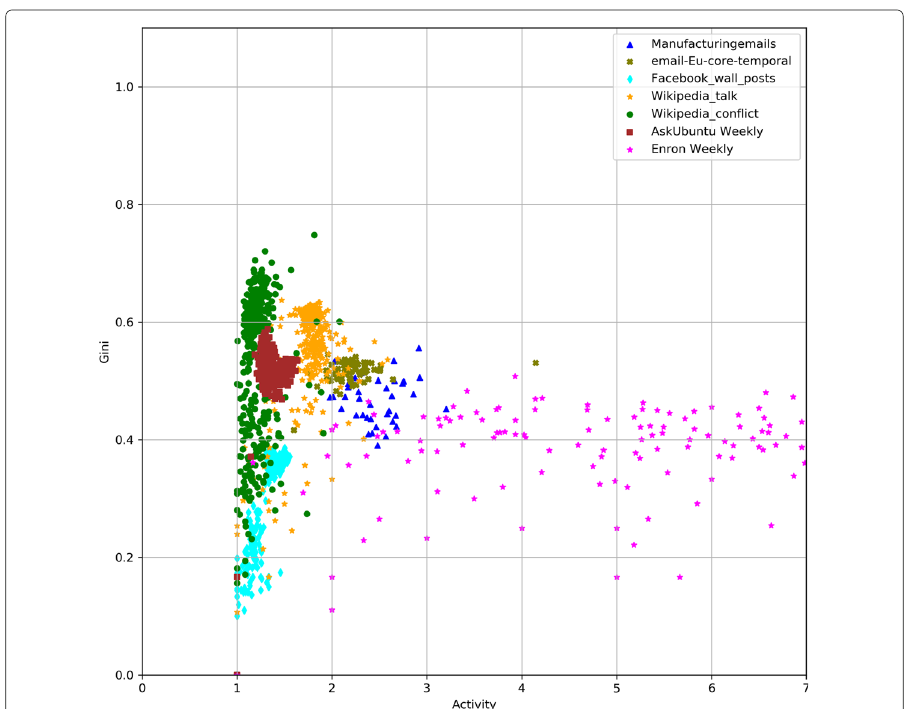
Fig. 7 Planar view of the weekly measured metrics, Activity Intensity (axis x) and Dominance Inequality (axis y) for all datasets